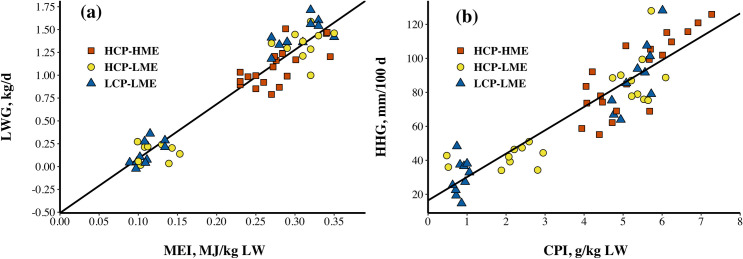
Effect of metabolizable energy (ME) intake (MEI) on liveweight gain (LWG; a; Y = -0.507 +5.95X, R2 = 0.92, RSE = 0.16, P < 0.001) and crude protein (CP) intake (CPI) on hip height gain (HHG; b; Y = 16.41 + 13.75X, R2 = 0.82, RSE = 13, P < 0.001) of steers fed high CP content and high ME intake (HCP-HME), high CP content and low ME intake (HCP-LME) and low CP content and low ME intake (LCP-LME).Each symbol represents the mean for an individual steer from Phase 1 and Phase 2 of the experiment.